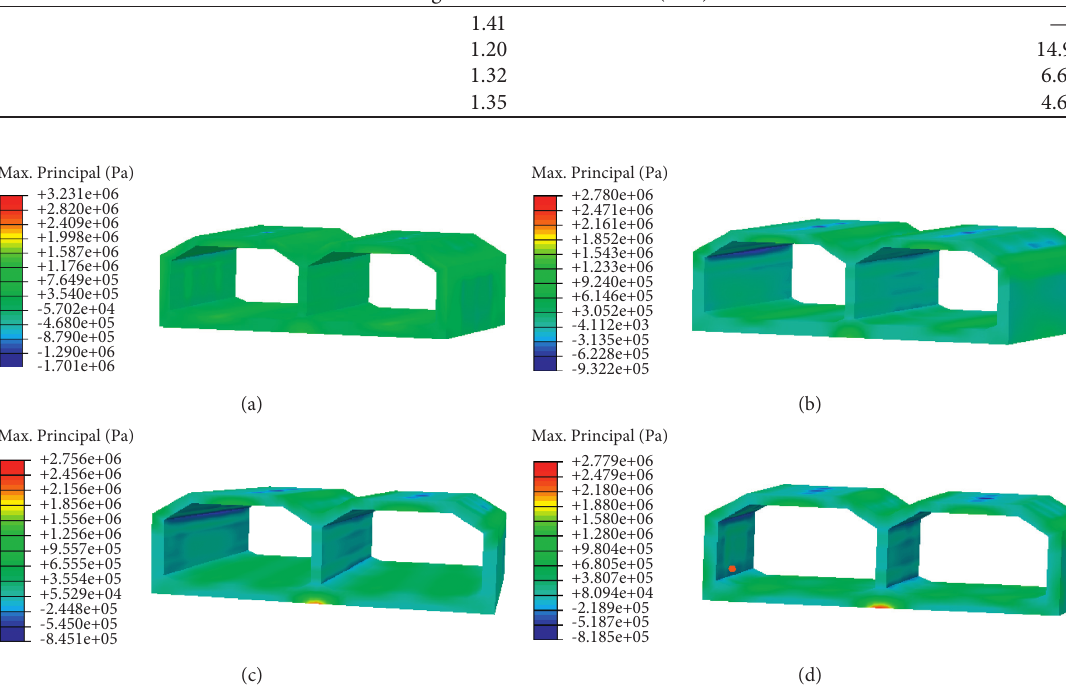
Figure 6: Cloud chart of maximum principal stress of tunnel lining. (a) Condition 1; (b) Condition 2; (c) Condition 3; (d) Condition 4. Min. Principal (Pa) +3.768e+04